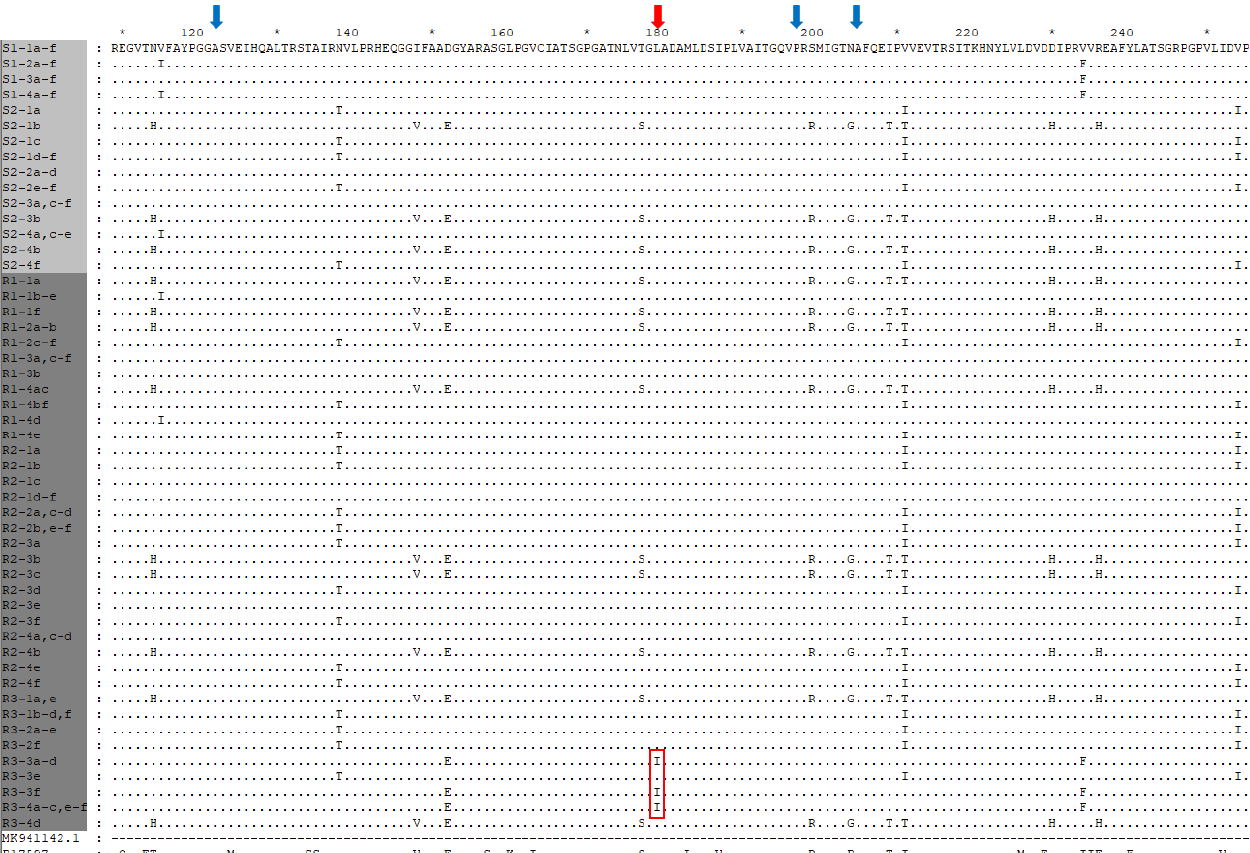
Figure 1. The alignment of Centaurea cyanus ALS amino acid sequences encompassing pyrimidine (PYR) binding domain of pyruvate oxidase (POX) and related protein regions. The sequences were derived from the plants susceptible (S) and resistant (R) to Lumer 50 WG. The numbers in the sequence names represent the plant number; a–f—clone name; MK941142— C. cyanus ALS sequence GenBank accession number (the nucleotide sequence was translated to amino acid sequence); P17597— Arabidopsis thaliana ALS amino acid sequence GenBank accession number. The red frames and red arrows indicate amino acid mutations found in C. cyanus R plants. The blue arrows indicate the positions of mutations known for conferring resistance to ALS-inhibiting herbicides at positions A122, P197, and A205, respectively. The amino acid numbering refers to A. thaliana ALS sequence.